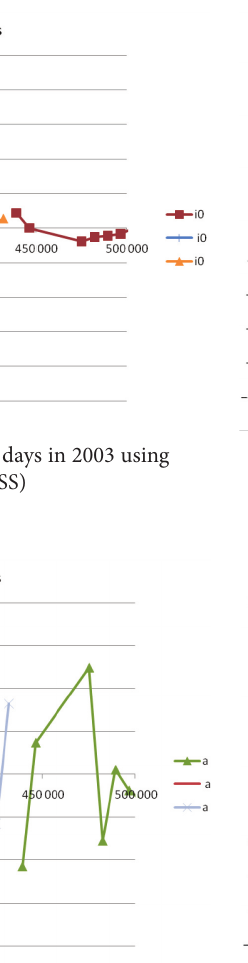
Fig. 3. a semi-major axis of three stormy days in 2003 using cPOS stations (KRSS)